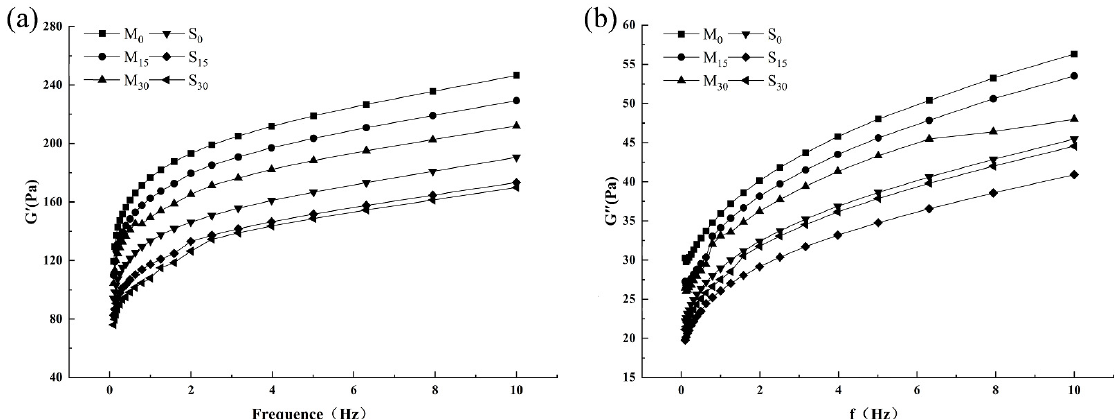
Figure 5. Frequency dependence of the storage modulus (G ′ ) and loss modulus (G ″ ): ( a ) storage modulus (G ′ ) of the fermented soymilk and milk mixtures of the two mixed fermentation methods during storage and ( b ) loss modulus (G ′ ) of the fermented soymilk and milk mixtures of the two mixed fermentation methods during storage.